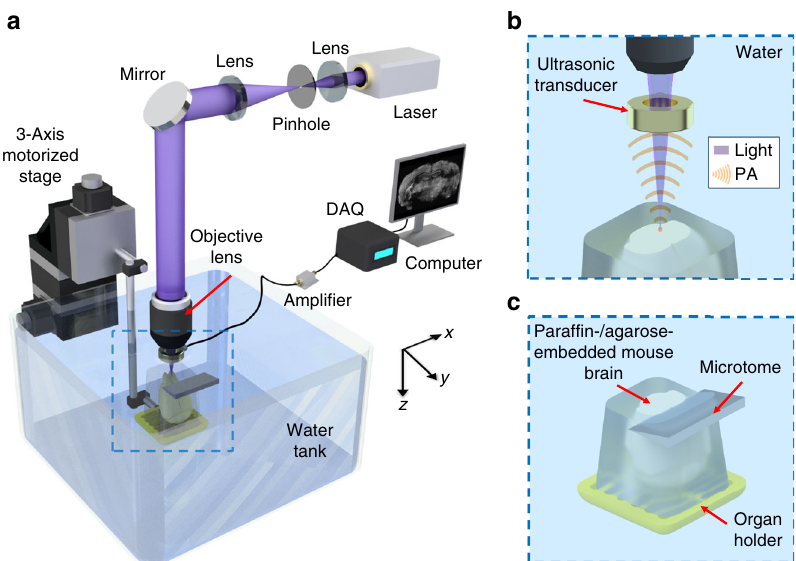
Fig. 1 Schematic of the mPAM system for whole-organ imaging and sectioning. a The UV laser beam is fi rst spatially fi ltered and expanded by a pair of lenses and a pinhole. The beam is then focused through an objective lens and passed through a ring-shaped ultrasonic transducer onto the surface of the paraf fi n-/agarose-embedded organ (e.g., a mouse brain), which is placed inside a water tank on top of a sample holder. Some generated acoustic waves propagate backward and reach the ring-shaped focused ultrasonic transducer. The received acoustic pressure is transduced into an electric signal, which is then ampli fi ed and recorded by a data acquisition (DAQ) card. During data acquisition, a maximum amplitude projection image from the measured B-scan data is displayed on a computer screen in ~1 s. By raster scanning the sample holder, a maximum amplitude projection image of the exposed tissue surface is also acquired. The imaged surface is then sectioned by a microtome, and a new surface is imaged automatically. This process continues until the sectioned layers reach the preset depth. b Close-up of the blue dashed region in a during imaging. The UV light passes through the ring-shaped focused ultrasonic transducer, inducing acoustic waves which are partially back-propagated and received by the same ultrasonic transducer. c Close-up of the blue dashed region in a during sectioning. The imaged surface ’ s (cross-section) is being cut by the